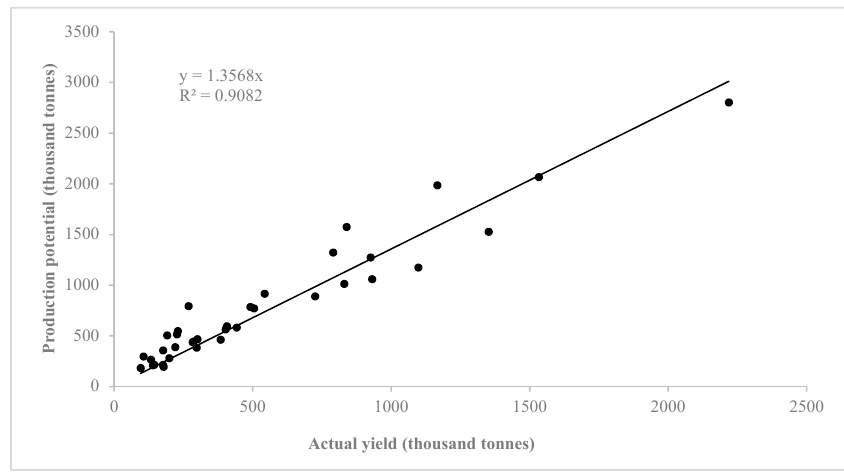
Figure 3. Comparison between production potential and actual yields in each county in 1975, 2000 and 2013.